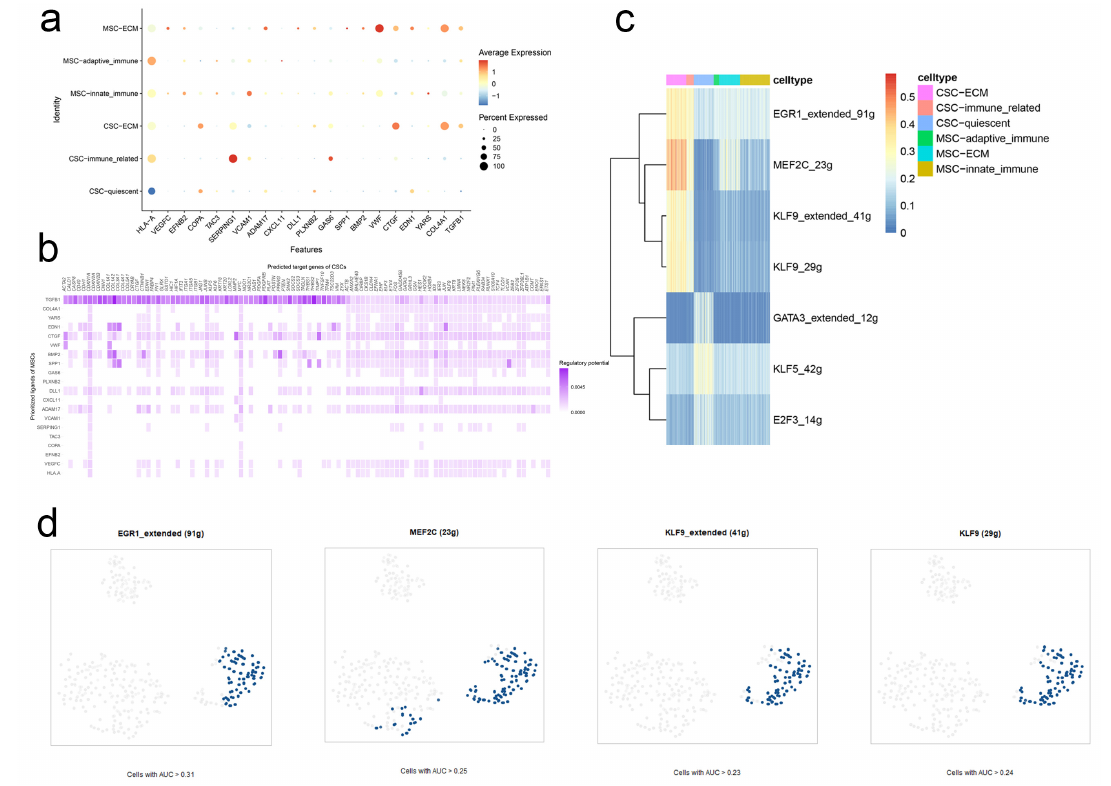
Figure 2. Stem. Sig. derived from intercellular communication networks. ( a ) The expression profiles of the top 20 ligands in the communication network. ( b ) The ligand-receptor network was constructed by NicheNet. ( c ) Activated regulons identified by SCENIC. ( d ) Regulons EGR1, MEF2C, and KLF9 were highly activated in CSCs.